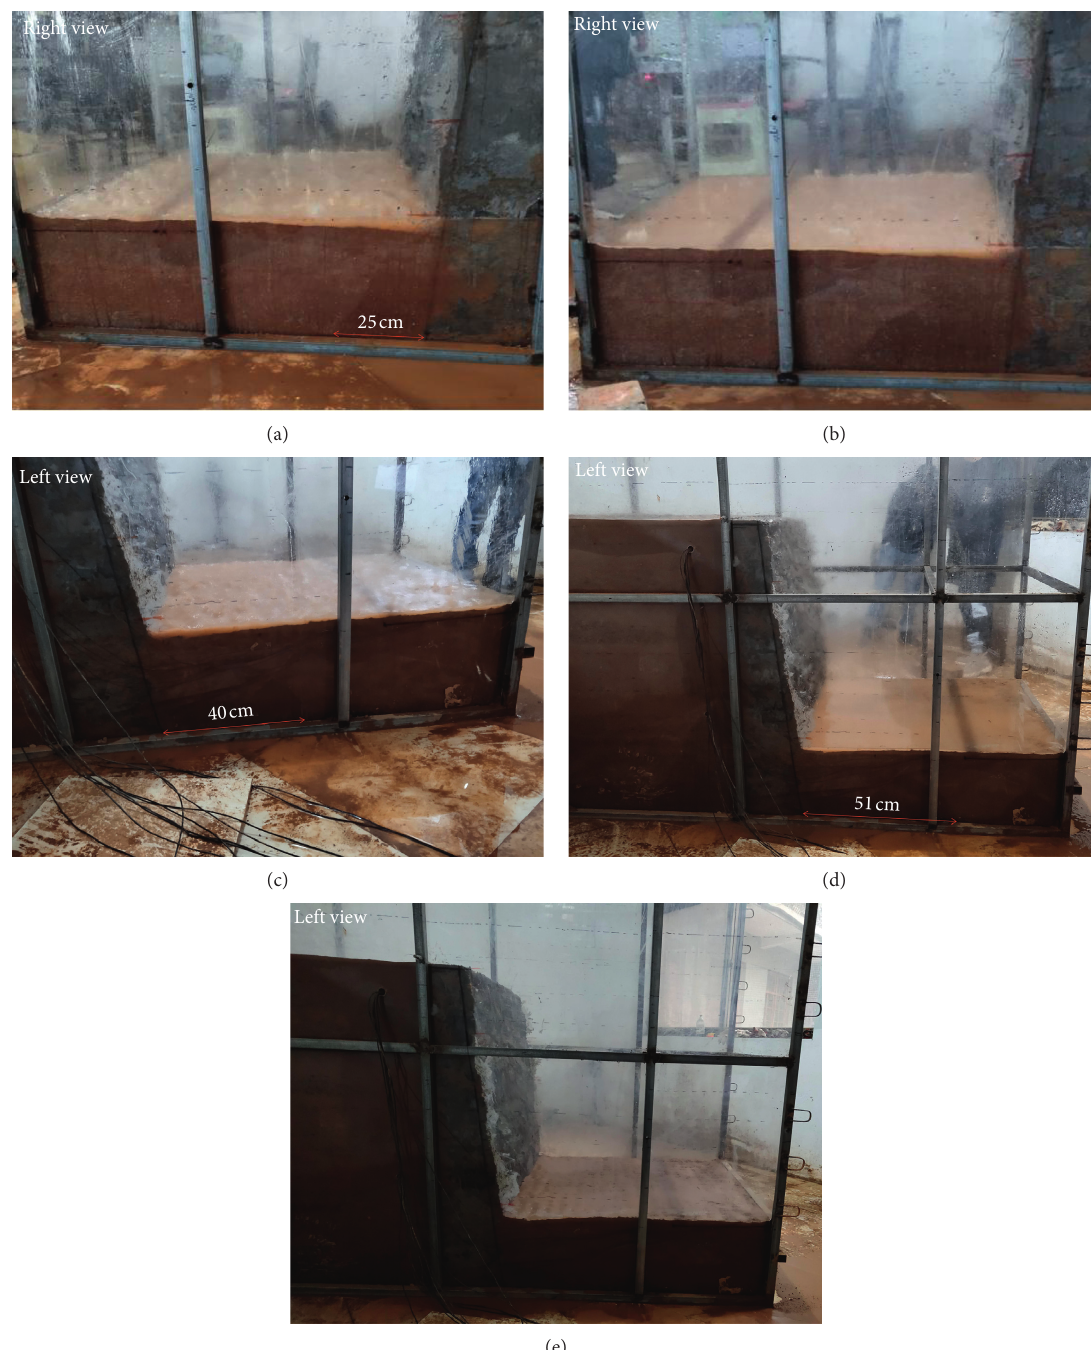
Figure 8: Rainwater infiltration in front of the retaining wall within the first year. (a) First rainfall lasted for 20 minutes. (b) First rainfall lasted for 45 minutes. (c) First rainfall lasted for 60 minutes. (d) First rainfall lasted for 120 minutes. (e) 5.2 hours after the first